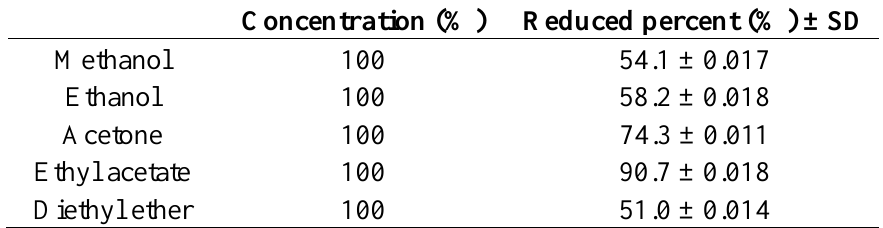
Table 4. Decreased percent of chlorophyll by organic solvent-induced membrane destruction.